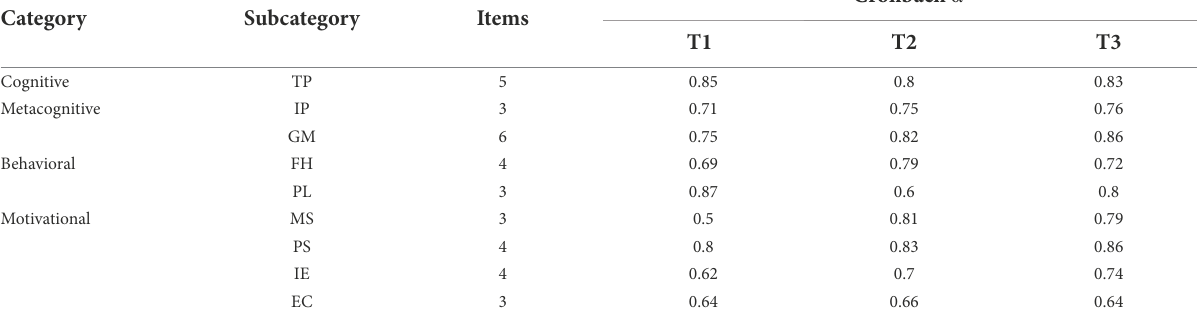
Category Subcategory